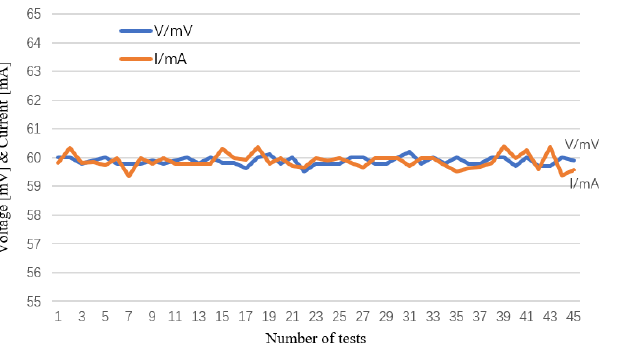
Figure 9. Data results from laboratory experiment.